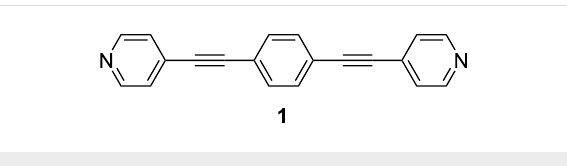
Figure 1: Chemical structure of 1,4-bis(pyridin-4-ylethynyl)benzene ( 1 ).